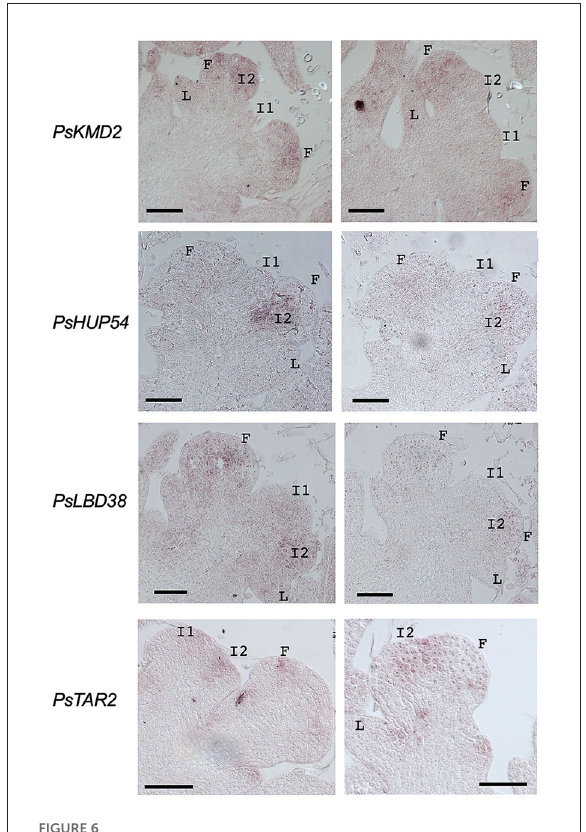
FIGURE6 Expression analysis by in situ hybridization in pea inflorescence apices of selected candidates for VEG1 target genes. Sections of wild-type pea inflorescence apices were hybridized with anti-sense probes for the genes PsKMD2 , PsHUP54 , PsLBD38, and PsTAR2 . L, leaf primordium; I1, primary inflorescence meristem; I2, secondary inflorescence meristem; F, floral meristem/primordium. Scale bars: 100 µ